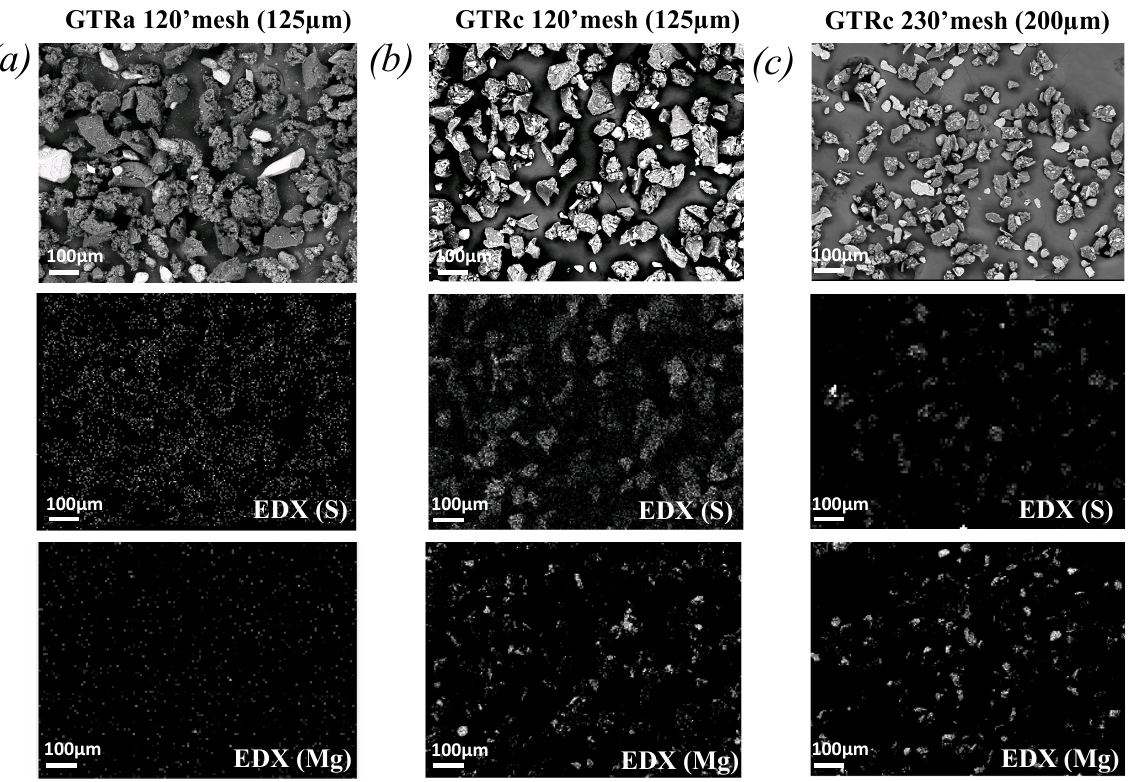
Figure 2. SEM images of GTR a particles with 120’s mesh ( a ), GTR c particles with 120’s mesh ( b ) and GTR c particles with 230’s mesh sieving ( c ) at a magnitude 100× (top figures). Mapping of the sulphur contained into the GTR particles (center figures) and mapping of the Mg (bottom figures) obtained from chemical analysis by EDX.